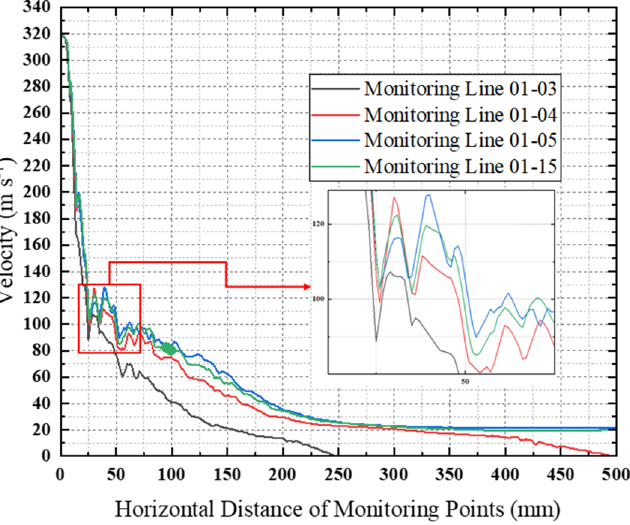
Figure 10. Line graph of the turbulent velocity of the equal-diameter nozzle flow field with a compressed air pressure of 212,782 Pa and a temperature of 303